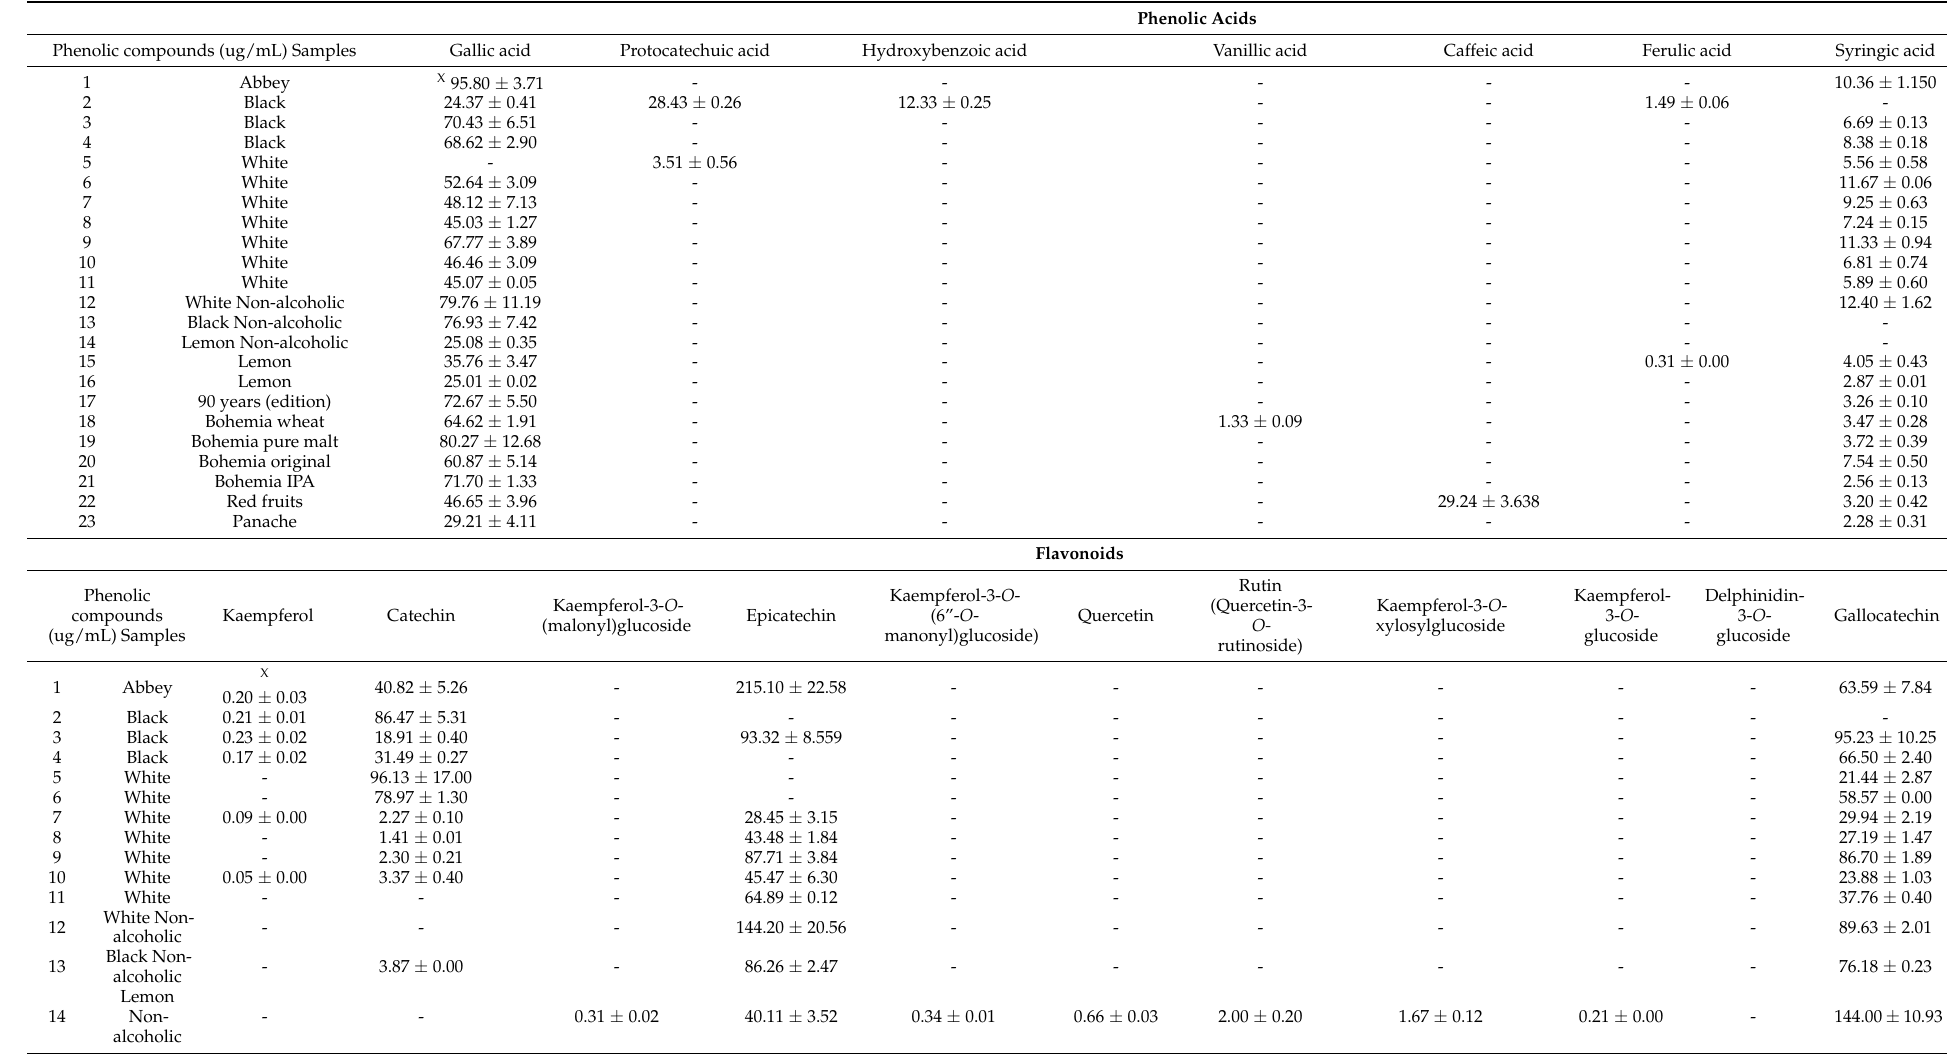
Table 3. Phenolic composition of Portuguese